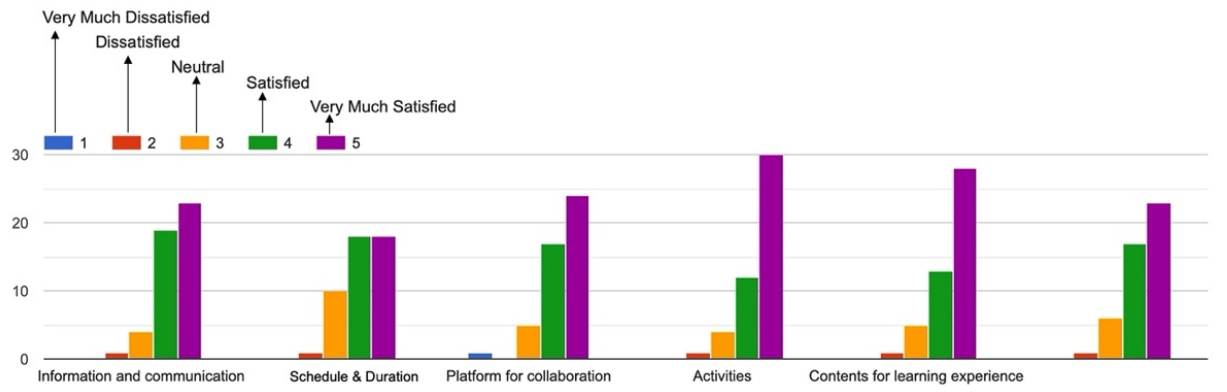
Figure 10. Satisfaction of students with the